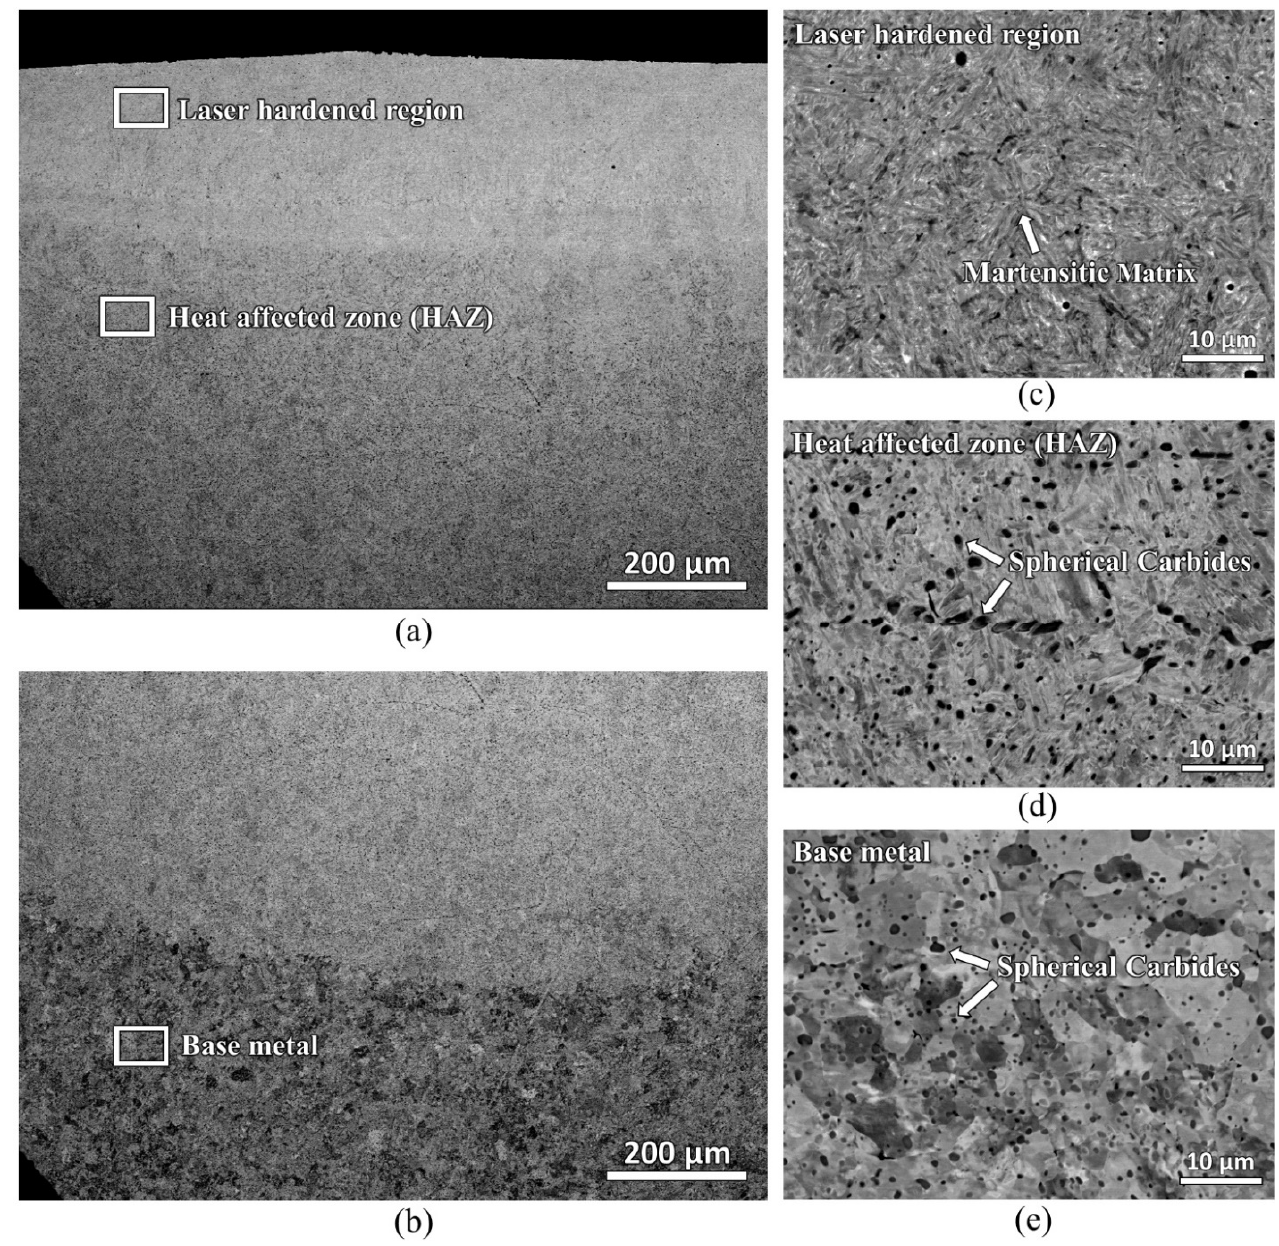
Figure 6. Backscattered electron micrographs of laser-hardened sample showing the microstruc- tures of three different locations: laser-hardened region, heat-affected zone (HAZ) and base metal: ( a , b ) lower magnification; ( c – e ) higher magnification.